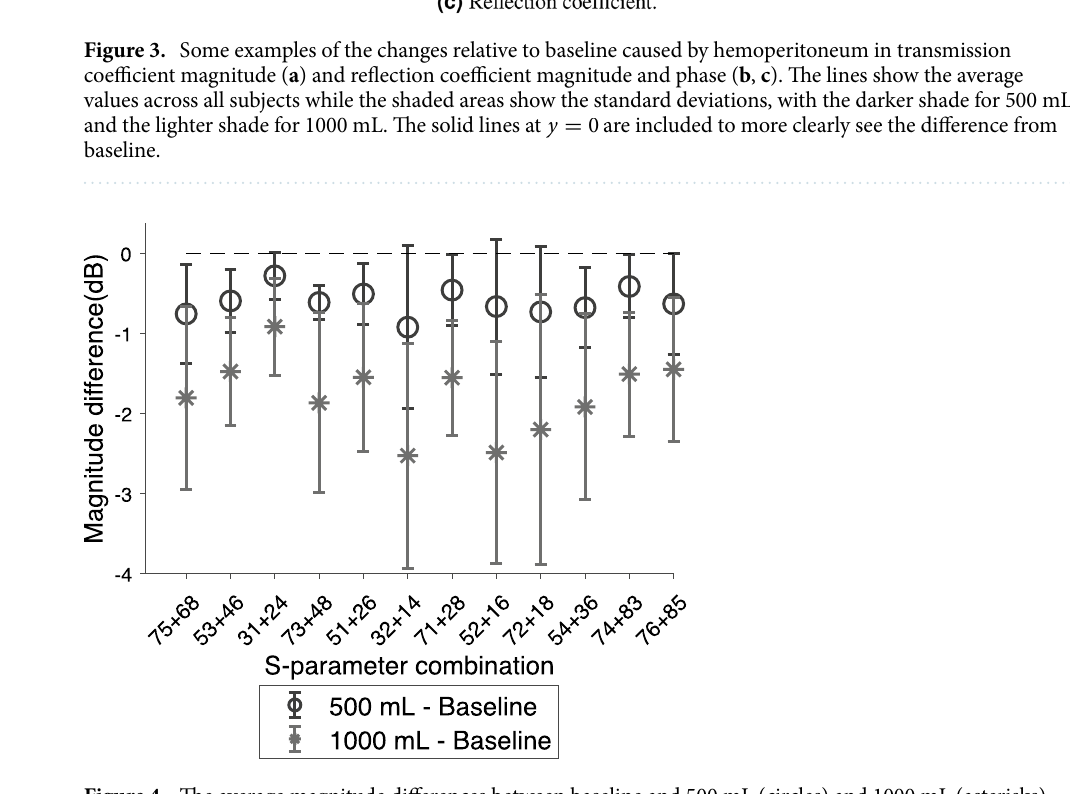
Figure 4. The average magnitude differences between baseline and 500 mL (circles) and 1000 mL (asterisks) hemoperitoneum, respectively, for all ten subjects and all symmetric pairs of transmission coefficients. The whiskers show the standard